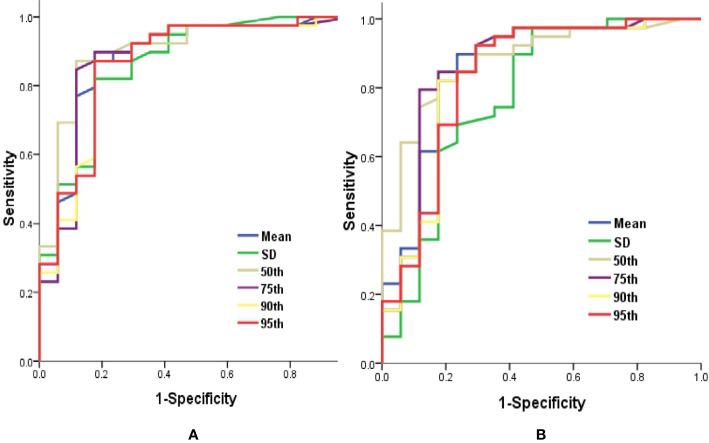
Graphs showed ROC curves of histogram parameters of Ktrans
(A) and Ve
(B) for differentiating the IDH1mutfrom IDH1wt gliomas. IDH, isocitrate dehydrogenase; IDH1mut, IDH1 mutant type; IDH1wt, IDH1 wildtype; Ktrans, volume transfer constant; ROC, receiver operating characteristic; Ve, volume of extravascular extracellular space per unit volume of tissue.